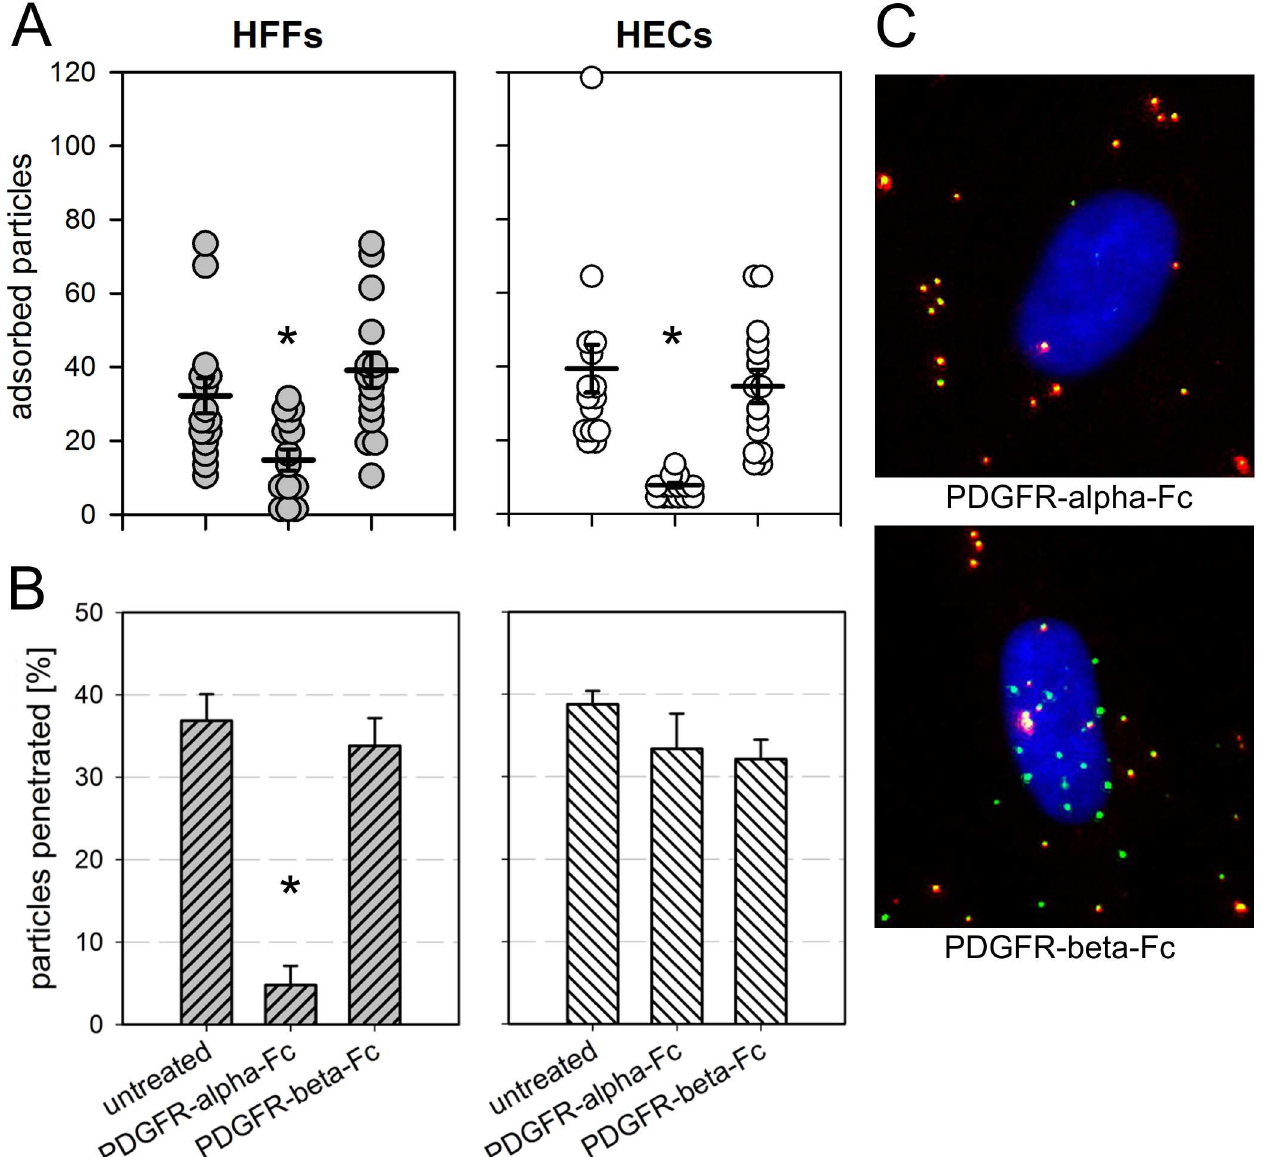
Fig 6. Effect of soluble PDGFR-alpha on adsorption and penetration of HCMV. Virus preparations of the dual fluorescent strain TB40-BAC KL7 -UL32EGFP-UL100mCherry were preincubated with 100 ng/ml solubleFc-chimeras for two hours and subsequently used to infect fibroblasts(HFFs) and endothelialcells (HECs) at 37˚C for two hours. (A) Adsorptionwas assessedby countingthe total numberof bound virus particlesper cell (pUL32-EGFP signalsregardlessof the pUL100-Cherry signals).Each dot representsone cell, mean values are indicatedby a horizontalline, and error bars representthe standard error of the mean (SEM). Significantdifferences as comparedto the untreatedcontrols are indicatedby asterisks. (B) The fraction of penetratedparticleswas determinedby counting the percentage of particles lackingthe envelope (particles without the pUL100-mCherry signal). Bars indicate the mean values of 15 cells per conditionand error bars represent the standarderror of the mean (SEM). One representative experiment out of three is shown. The significantdifference betweenPDGFR-alpha-Fc-treated HFFs and the untreatedcontrol is indicatedby an asterisk. C : Examples of microscopic images taken in HFFs. Enveloped virus particlesappearyellow due to an overlap of pUL32-EGFPsignalsand pUL100-Cherry signals. Penetratednon-envelopedparticles are only EGFP-positive. Nuclei were stainedwith